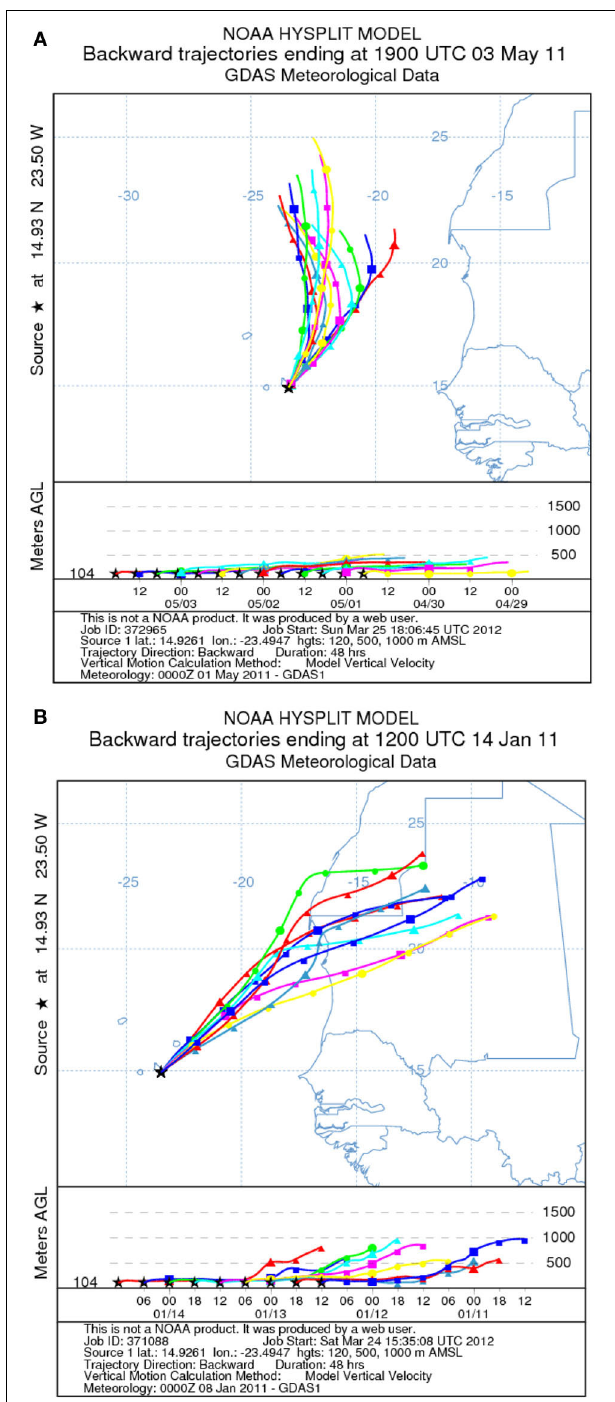
FIGURE 8 | Hysplit 48h backward trajectories of air masses arriving at Praia, for two distinct periods in 2011. (A) End of April and beginning of May, when PM 10 mass concentrations exhibited minimum values; (B) 11–14 January with strong dust transport from West Africa, when PM 10 mass concentrations were peaking. Each color represents a 48 backward trajectory. Trajectories were evaluated at each 6h